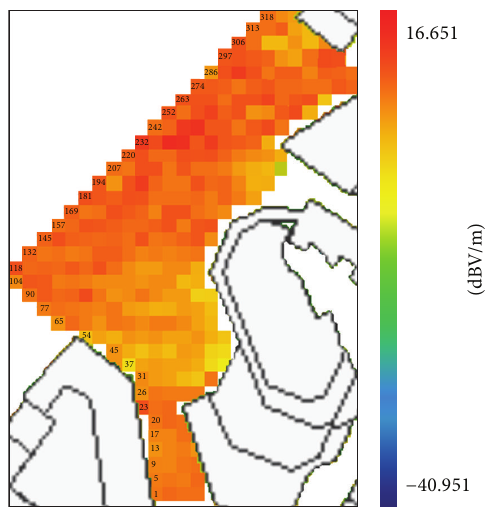
Figure 3: Total electric field strength software prediction map.